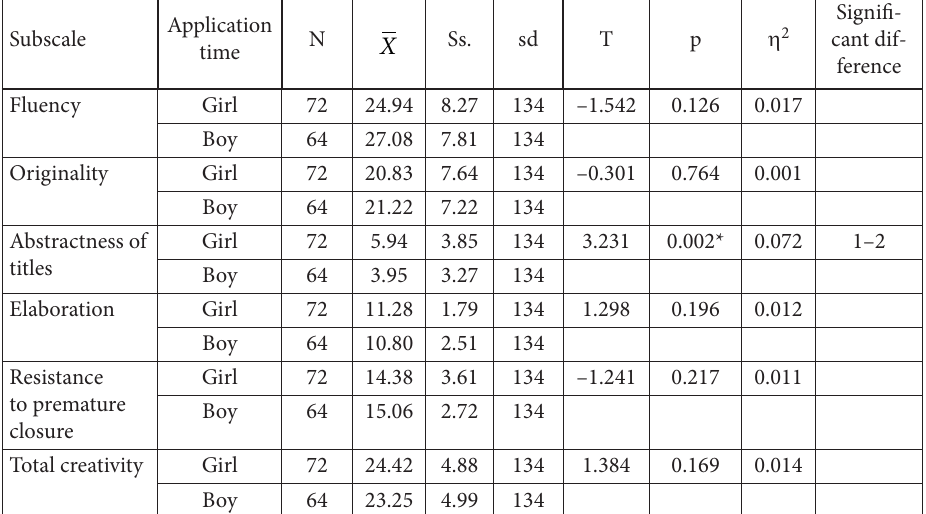
Table 5. T-test results of the creativity scores of the adolescents in the 9th grade based on gender (source: created by author)